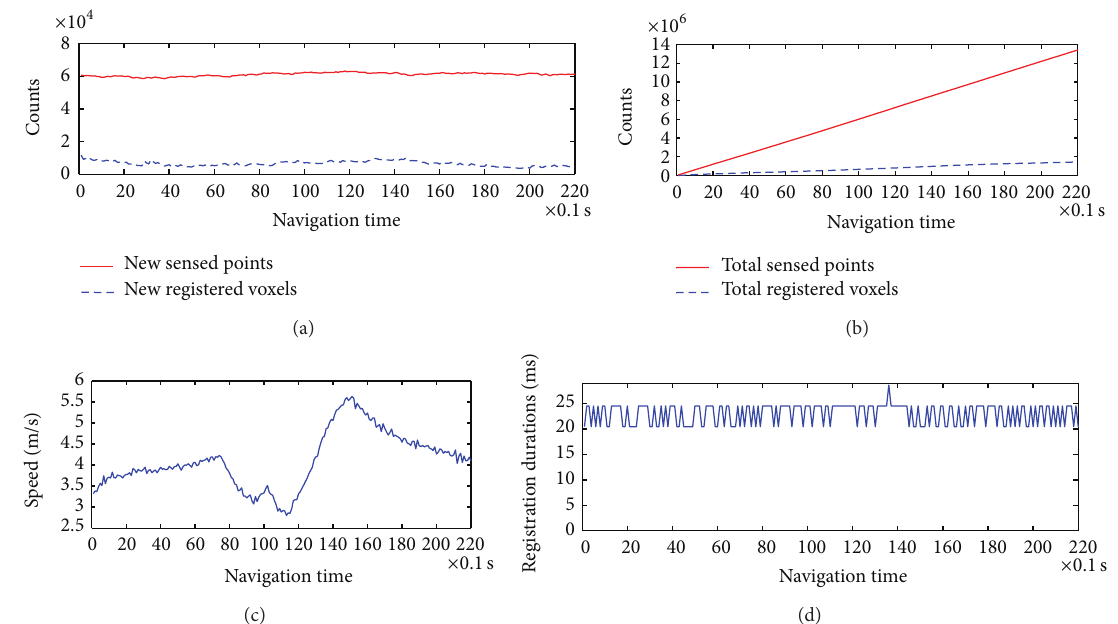
Figure 9: 3D point cloud registration using the voxel-based flag map. (a) Counts of new sensed points and registered voxels. (b) Counts of total sensed points and registered voxels. (c) Driving speed. (d) Registration durations of point clouds.